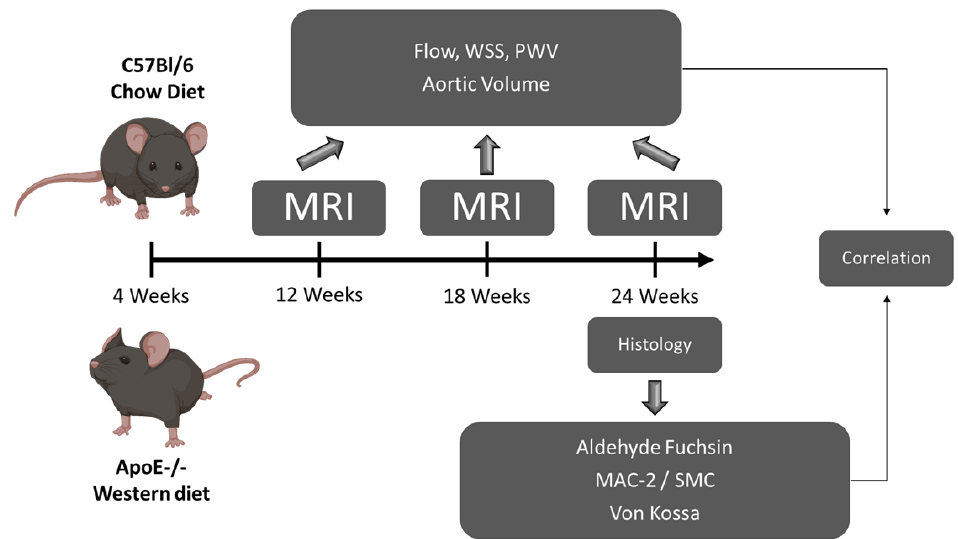
Figure 1. Study design. WT mice were fed a chow and Apoe − / − mice a Western diet starting at the age of 4 weeks. At 12, 18 and 24 weeks, flow and WSS were measured with 4D-PC MRI. After 24 weeks, aortas were analyzed histologically for collagen, SMC and MAC content, necrotic core size and calcification. Obtained data were correlated with spatially resolved WSS and OSI values.